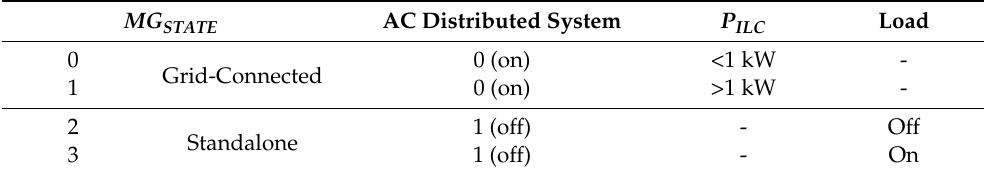
Table 1. State values of